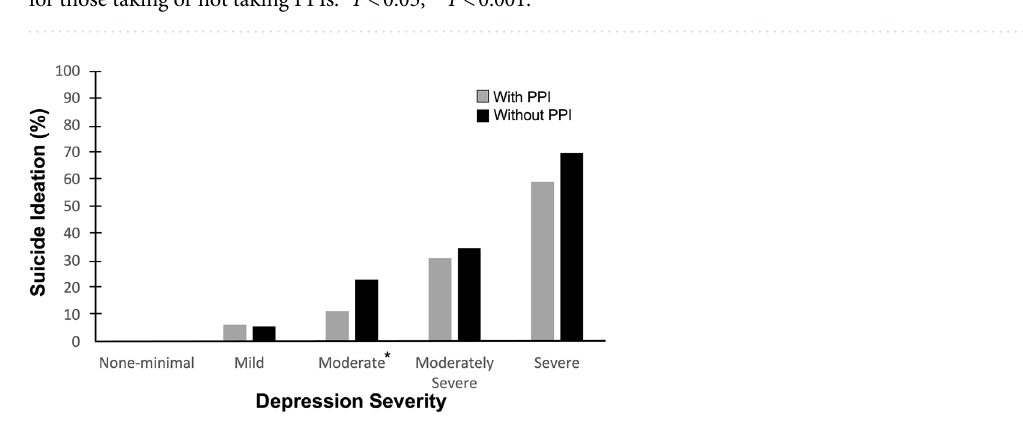
Figure 2. Weighted percentage of participants who had ( a ) suicidal ideation and ( b ) depression by age group for those taking or not taking PPIs. * P < 0.05; ** P < 0.001.